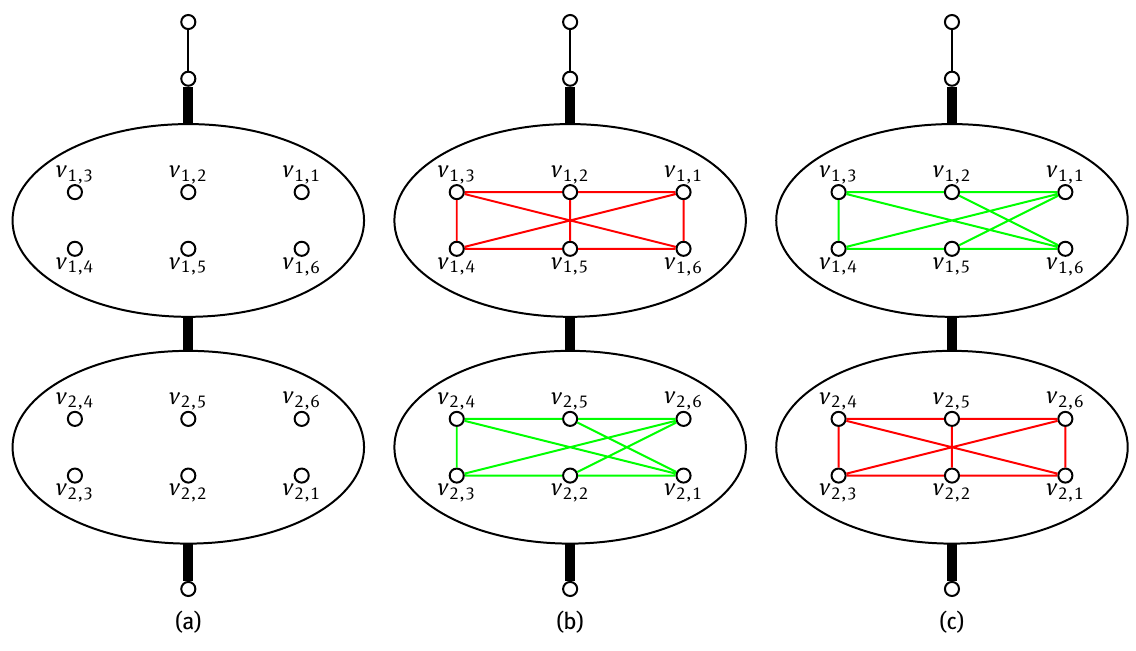
Figure 6: Let the thick edges represent all possible edges between a vertex and a cluster of vertices. (a) A graph G with V 1 = { v 1,1 , v 1,2 , v 1,3 , v 1,4 , v 1,5 , v 1,6 } and V 2 = { v 2,1 , v 2,2 , v 2,3 , v 2,4 , v 2,5 , v 1,6 } which are (co-degree) cousins. (b) A graph G